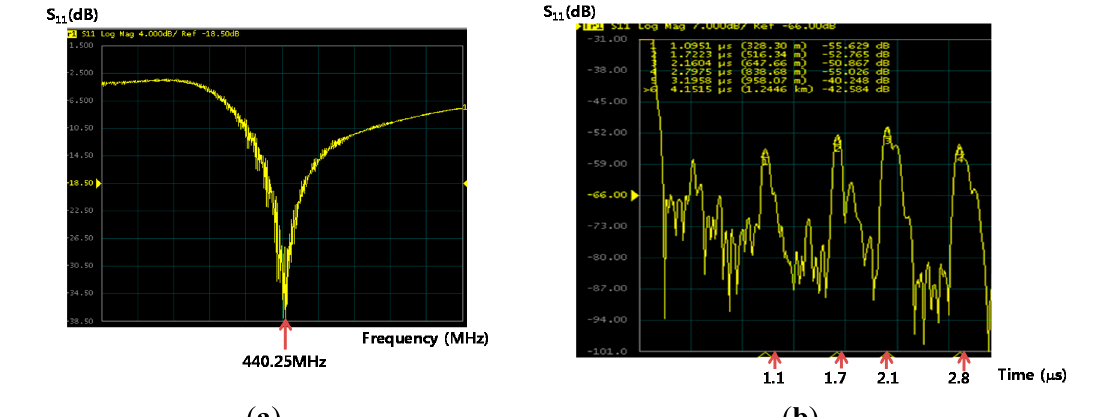
Figure 8. Experimental results of the reflection coefficient S 11 obtained out of the fabricated device in ( a ) frequency domain and ( b ) time domain. A 440 MHz center frequency and reflection peaks were observed on the network analyzer